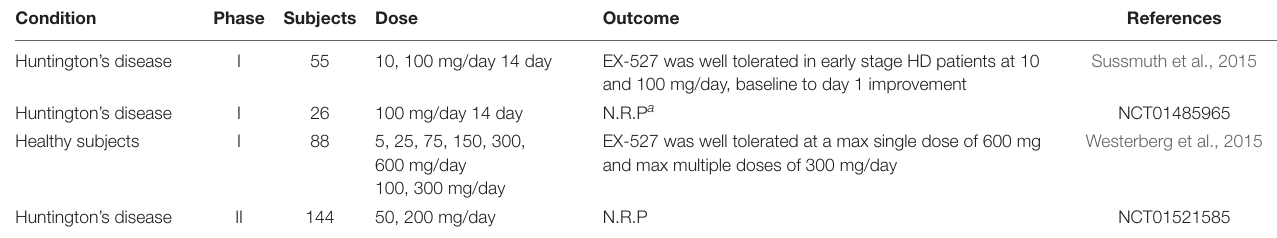
TABLE 12 | Clinical trials of EX-527 for Huntington’s disease. Condition Phase Subjects Dose